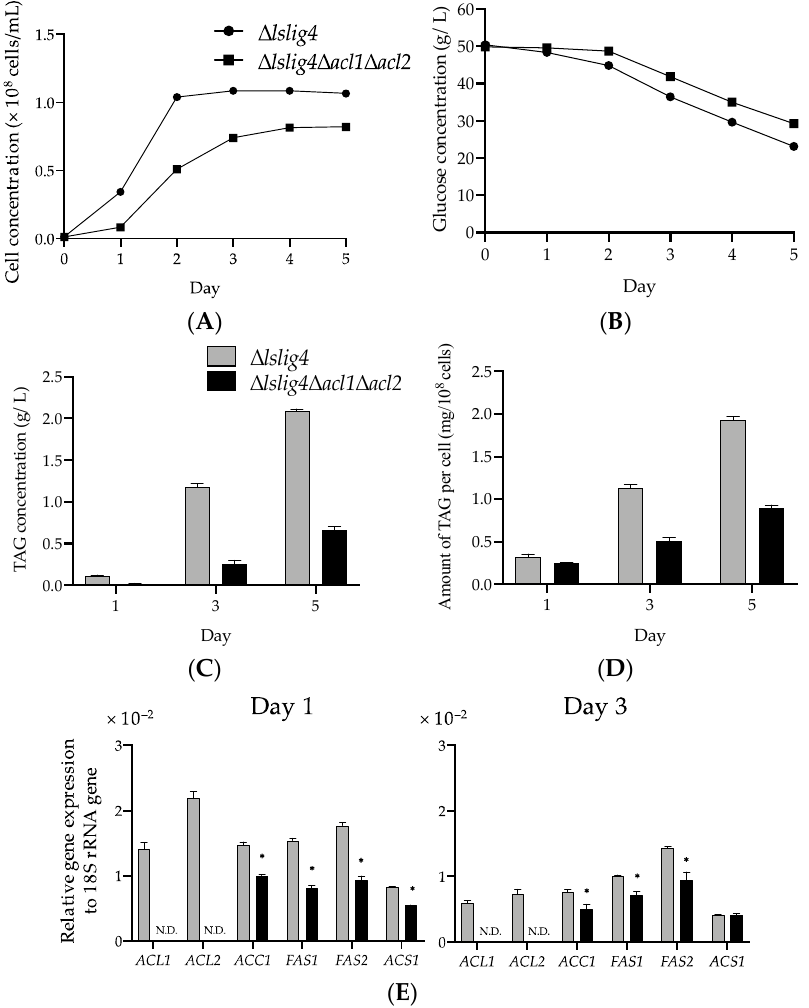
Figure 5. The effect of ATP-citrate lyase deletion on TAG synthesis in an S medium containing glucose. ∆ lslig4 and ∆ lslig4 ∆ acl1 ∆ acl2 were cultured in an S medium containing glucose at 30 °C for five days in a small-scale culture. Symbols: closed circles, ∆ lslig4 ; closed squares, ∆ lslig4 ∆ acl1 ∆ acl2 ; gray bars, ∆ lslig4 ; black bars, ∆ lslig4 ∆ acl1 ∆ acl2 . N.D. indicates not detected. ( A ) Cell concentration (cells/mL), ( B ) glucose concentration (g/L), ( C ) TAG concentration (g/L), ( D ) amount of TAG per cell (mg/10 8 cells), and ( E ) relative expression levels of genes involved in acyl-CoA synthesis ( ACL1 , ACL2 , ACC1 , FAS1 , FAS2 , and ACS1 ). The transcription levels with relative quantitative method normalized by 18S rRNA. The data are indicated as the mean ± SEM of the three independent experiments. Asterisks indicate statistically significant differences between ∆ lslig4 and ∆ lslig4 ∆ acl1 ∆ acl2 ( t -test; * p < 0.05).